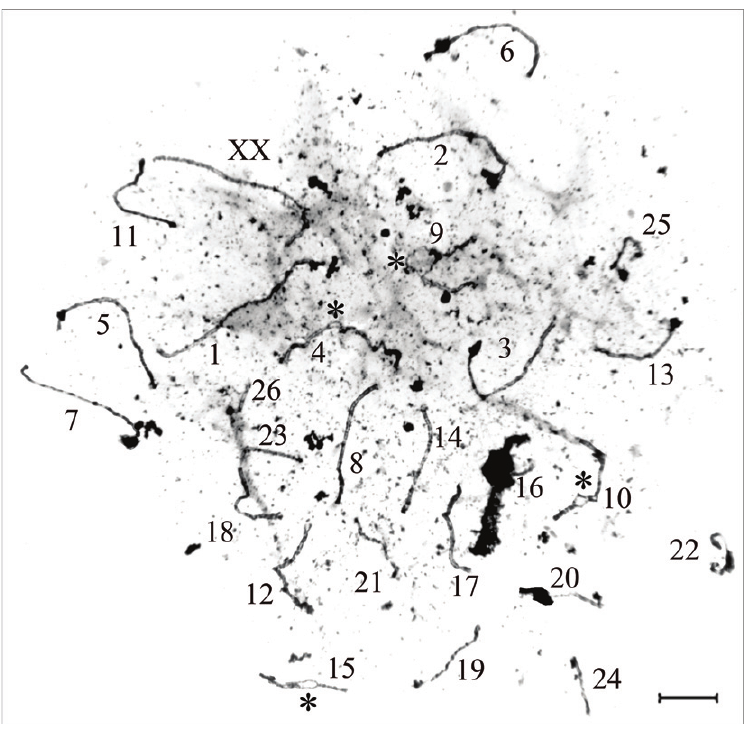
Fig. 2. Spread from an E. talpinus oocyte at early diplotene examined with transmission electron microscopy. Numbers of SCs correspond to numbers of metaphase chromosomes of E. talpinus (Romanenko et. al., 2007). Asynaptic zones of SCs are visible (snowfl ake). Bar = 3 μm